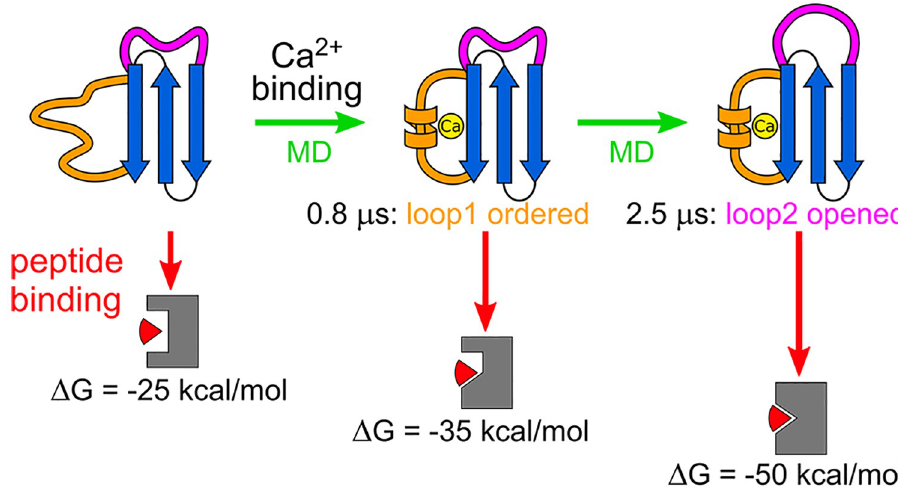
Fig 6. Schematic representation summarizing the effect of Ca 2+ binding on the sortase structure and on the sortase/sorting signal affinity.